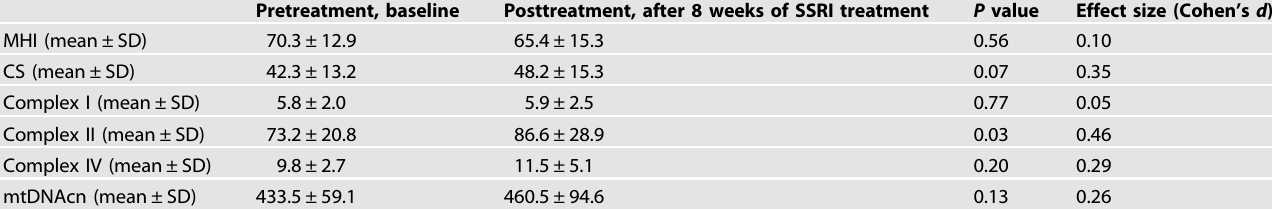
Table 3. Pre- and posttreatment mitochondrial markers in all MDD subjects undergoing 8 weeks of SSRI treatment. Pretreatment,